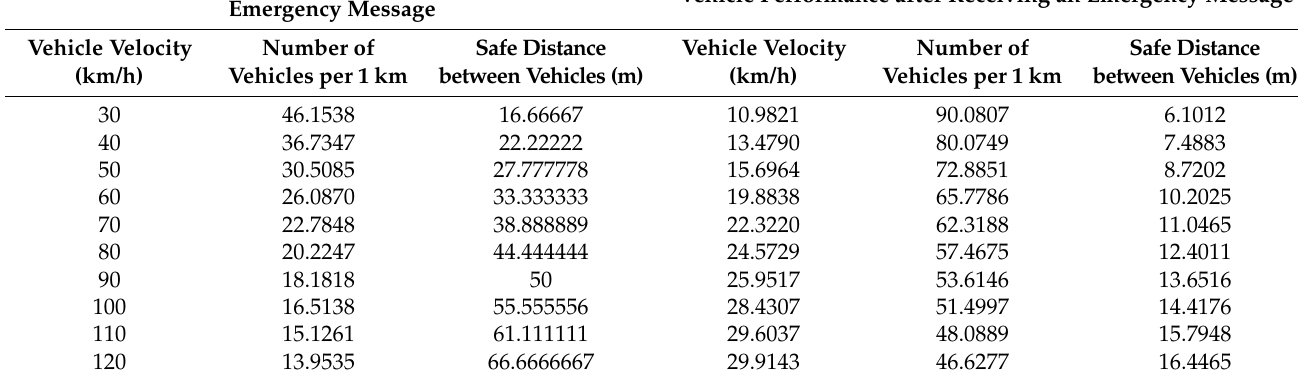
Table 2. Traffic and vehicle performance before and after receiving the emergency